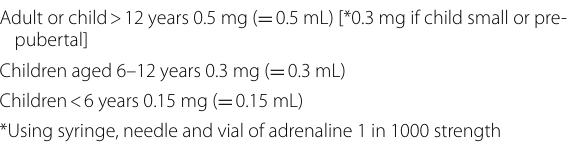
Table 2 The British National Formulary (BNF) and the Resus‑ citation Council UK dosages of adrenaline to be adminis‑ tered intramuscularly by healthcare